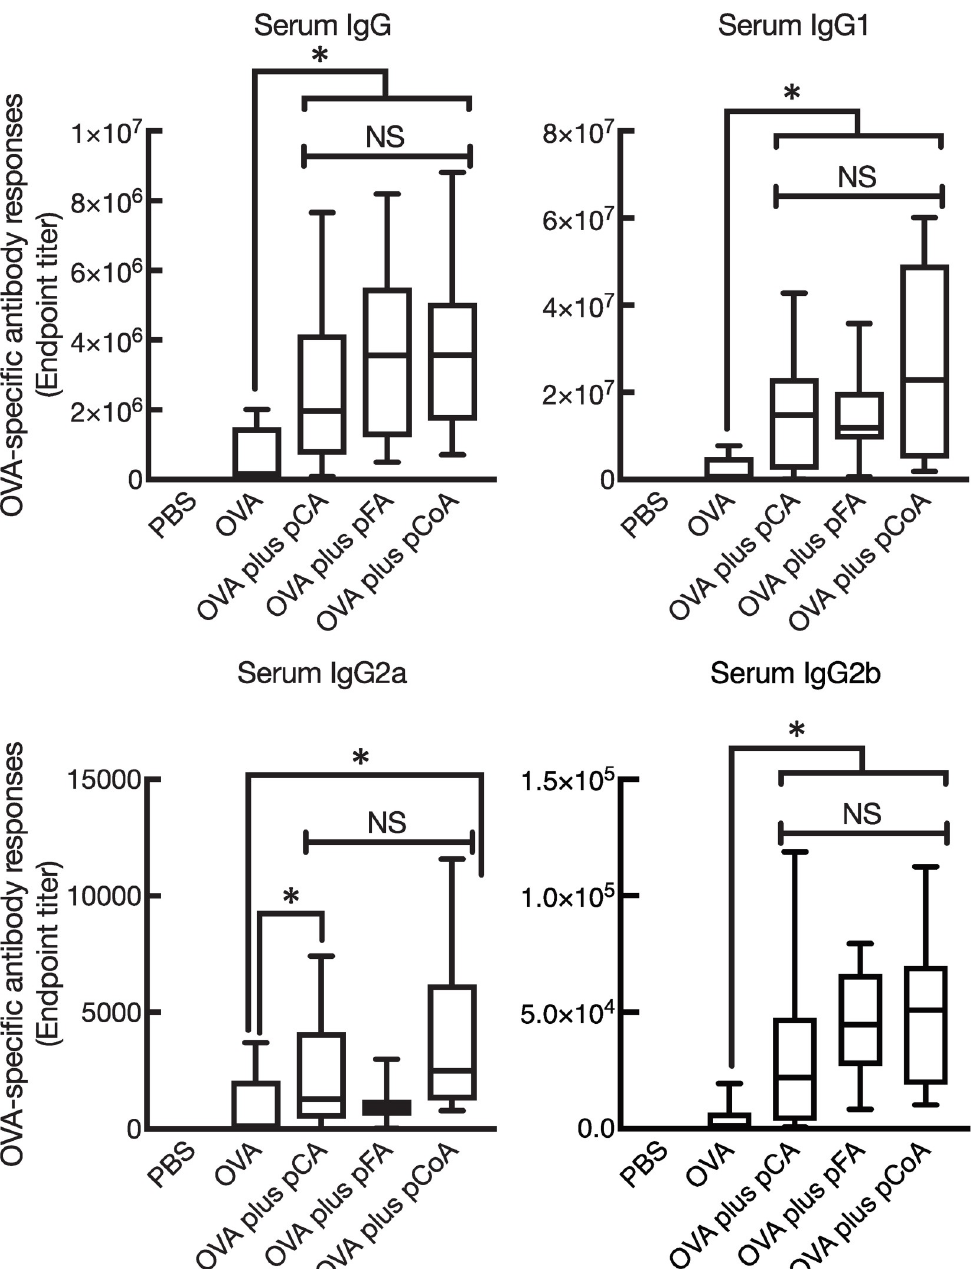
Fig 3. Enzymatically polymerised polyphenols promote antigen-specific systemic antibody responses. Female BALB/ cCrSlc mice were immunised three times intranasally (days 0, 7, and 14) with vehicle (PBS), OVA (2.5 μ g/mouse) alone, OVA (2.5 μ g/mouse) plus pCA (100 μ g/mouse), OVA (2.5 μ g/mouse) plus pFA (100 μ g/mouse), or OVA (2.5 μ g/mouse) plus pCoA (100 μ g/mouse). OVA-specific total IgG, IgG1, IgG2a, and IgG2b endpoint titres in sera at day 21 were detected by ELISA. The data were obtained from three biologically independent experiments. PBS, n = 9; OVA, n = 9; OVA plus pCA, n = 9; OVA plus pFA, n = 9; OVA plus pCoA, n = 9. The box-plot shows the median value with the 25th–75th percentiles and the error bars indicate the 5th–95th percentiles. Significance was calculated using the Kruskal-Wallis with Dunn’s post-hoc test: � p < 0.05.